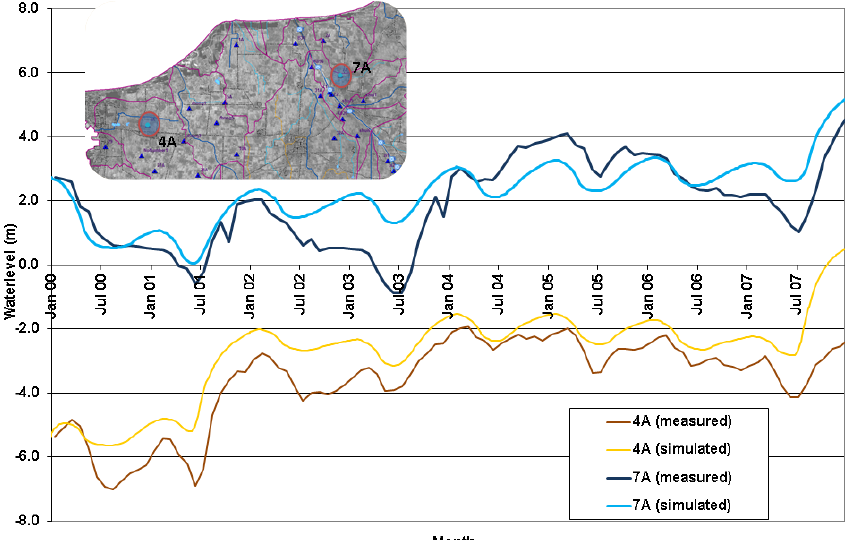
Figure 2. Measured and simulated results for two groundwater monitoring